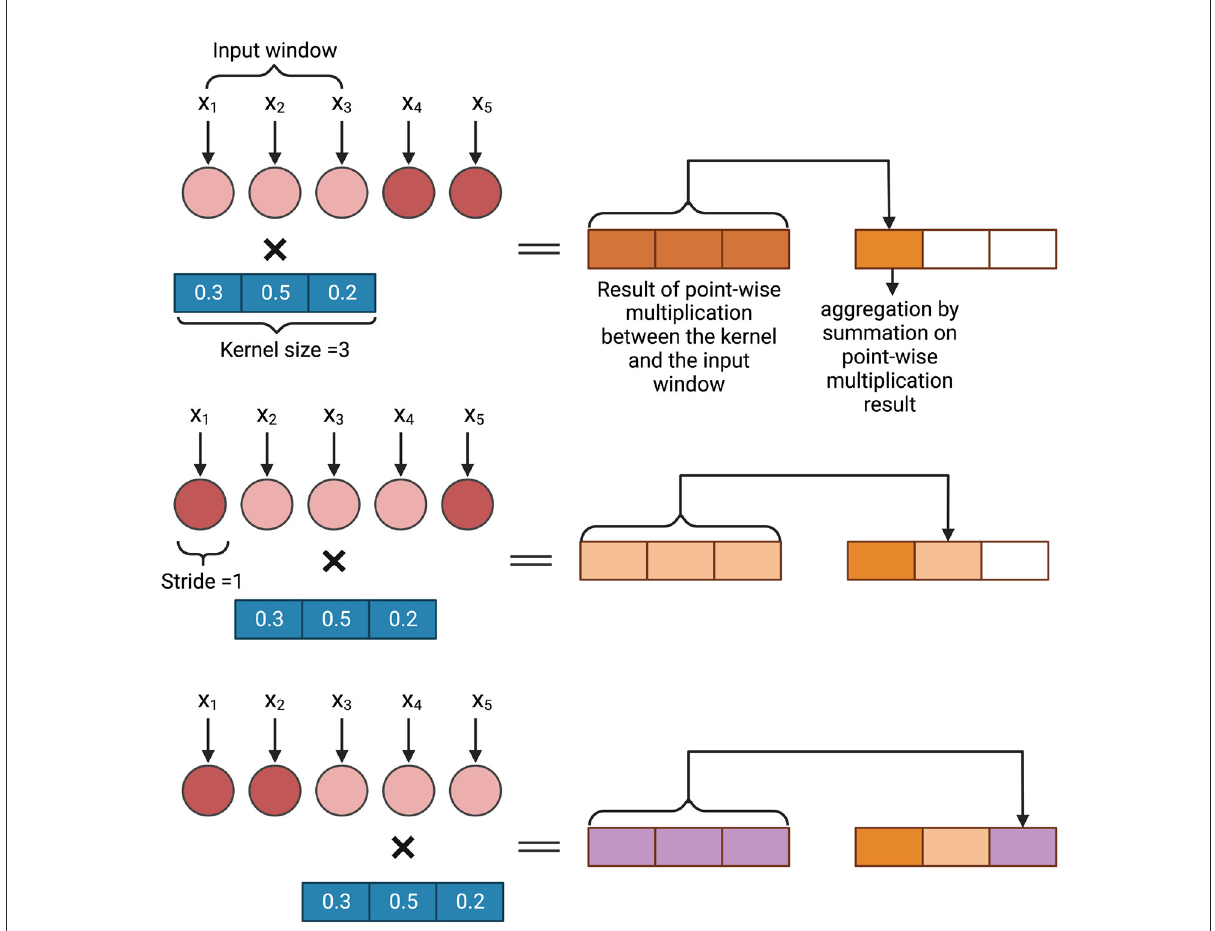
FIGURE3 An example of convolution operation on a one dimensional input vector. In GS, x i is a